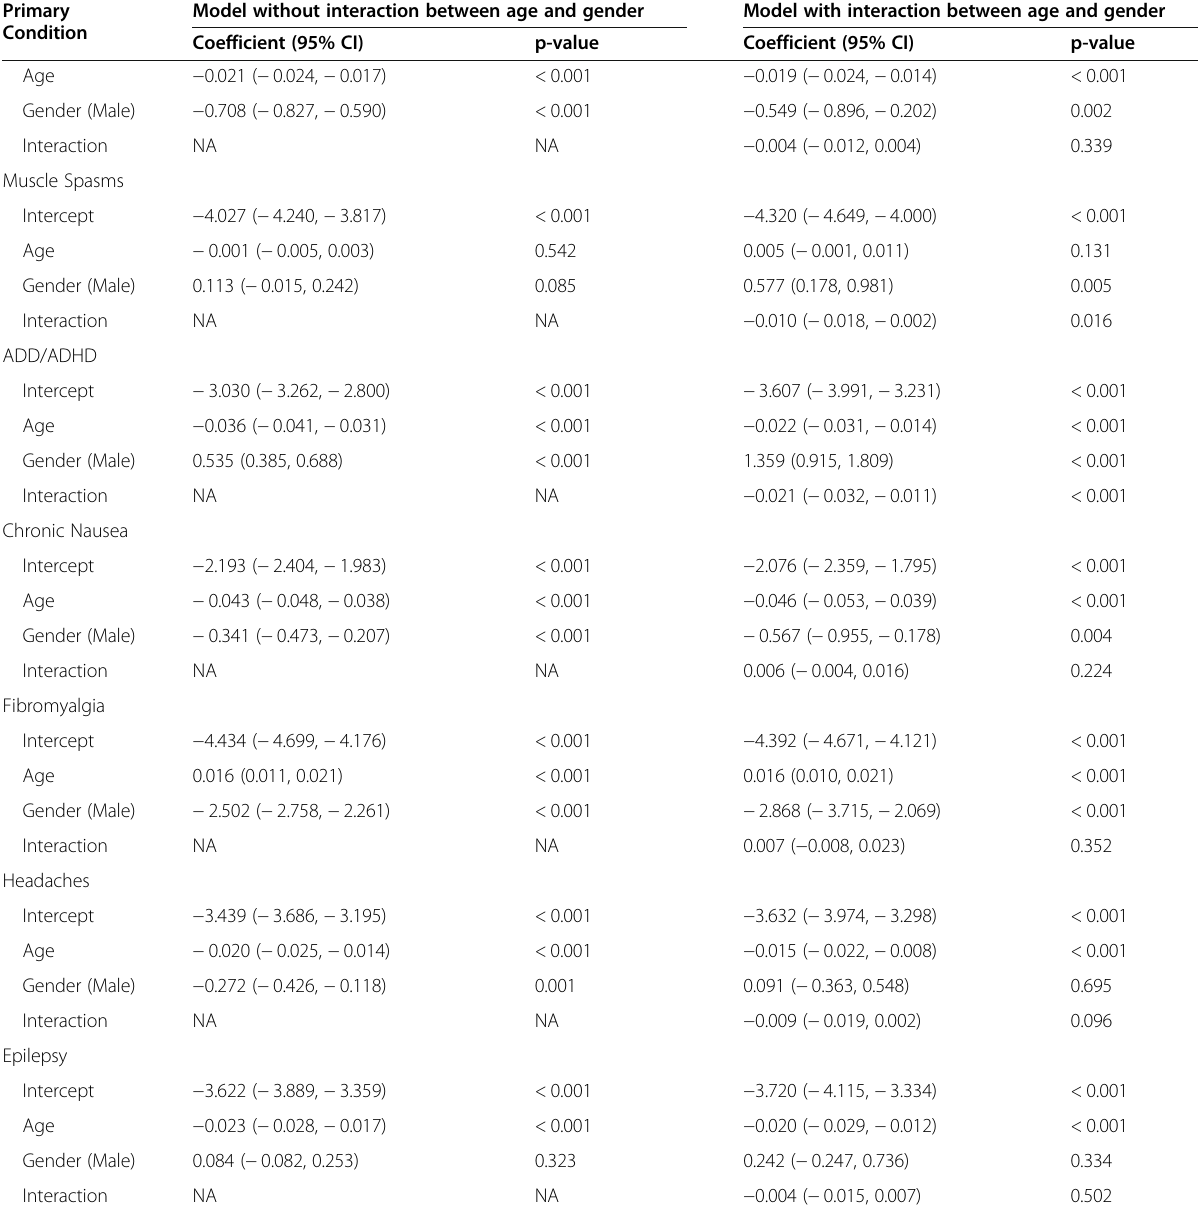
Table 6 Multivariate analysis results of differences in primary condition reported by 56,860 patients seeking medical cannabis certification by gender and age, with and without interaction (Continued)